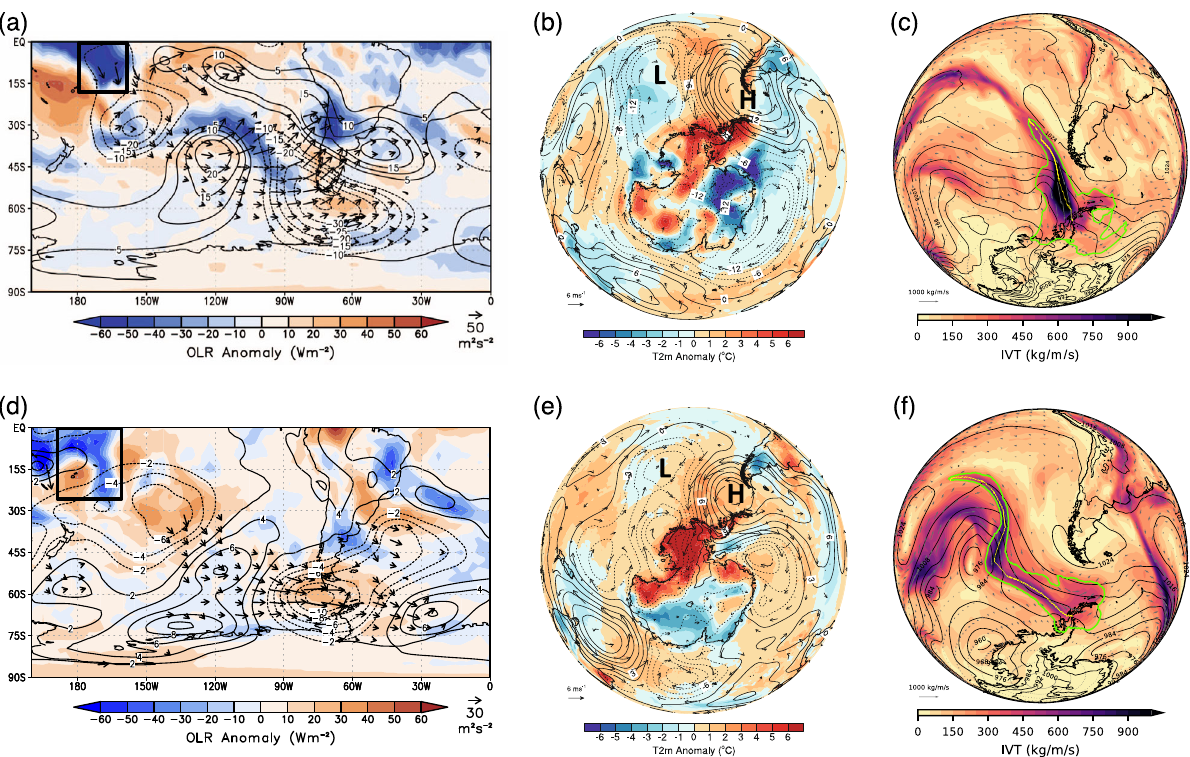
Fig. 3 The CPAC-forced circulation anomalies driving extreme high temperatures on the eastern Antarctic Peninsula. (top) The 24 March 2015 and (bottom) 6 February 2020 record-high temperature events. a The OLR (shaded), 200 hPa streamfunction (contoured) and 200 hPa stationary wave fl ux (vectors) anomalies and b surface air temperature (T2m, shaded), MSLP (contoured), and 10 m wind (vectors) anomalies for 22 – 26 March 2015, and c the vertically integrated moisture fl ux (IVT; shaded, vectors), MSLP (contours), and outline of the landfalling AR (green contour; IVT exceeding 85th percentile) and AR axis (yellow line; a pathway of maximum IVT) (Methods) at 06 UTC 24 March 2015. d , e are as in a , b except for 4 – 8 February 2020 and d is for the 850 hPa level, and ( f ) is as in ( c ) except for 06 UTC 6 February 2020. The CPAC OLR region is denoted with a black box in the upper left corner of ( a , d ), and the location of the high and low-pressure centers is given as an “ H ” and “ L ” , respectively, in ( b , e